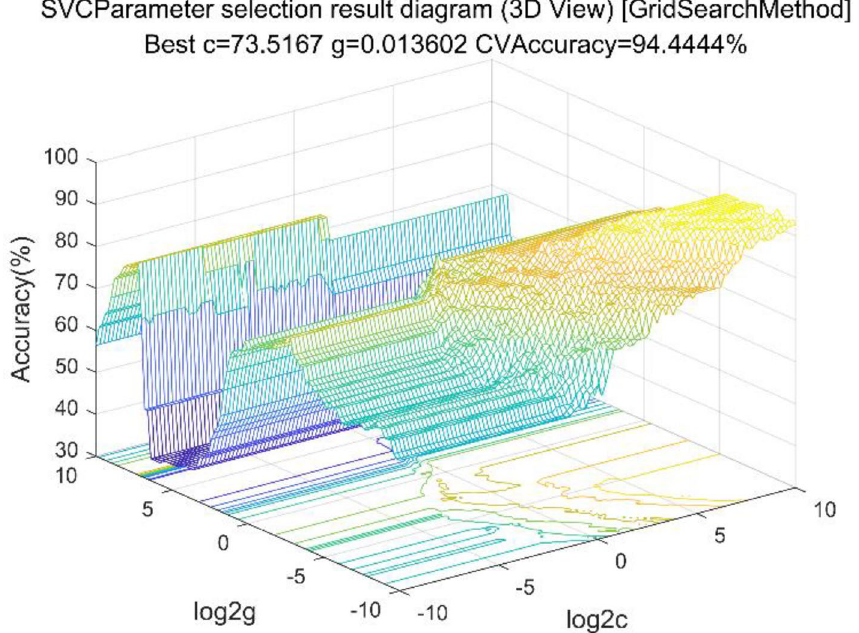
Figure 3. SVC Parameter selection result.